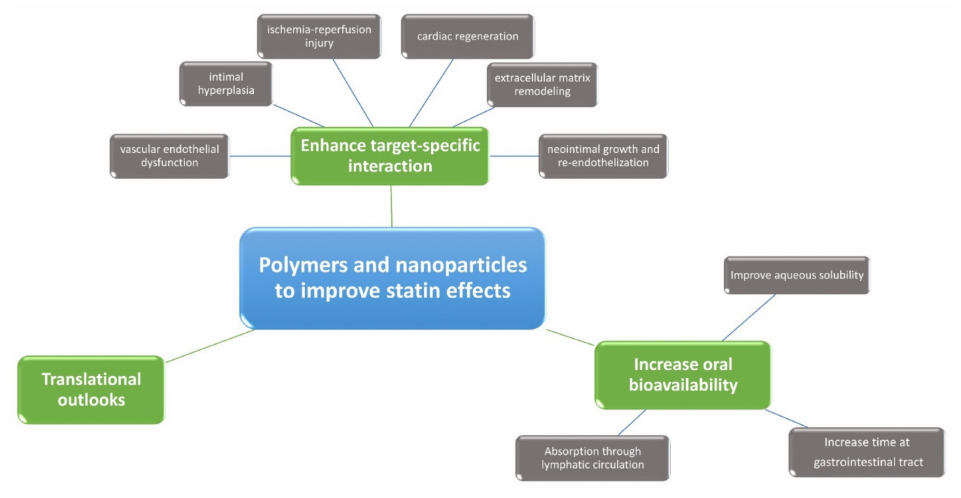
Figure 1. Polymers and nanoparticles for statin delivery: main effects.